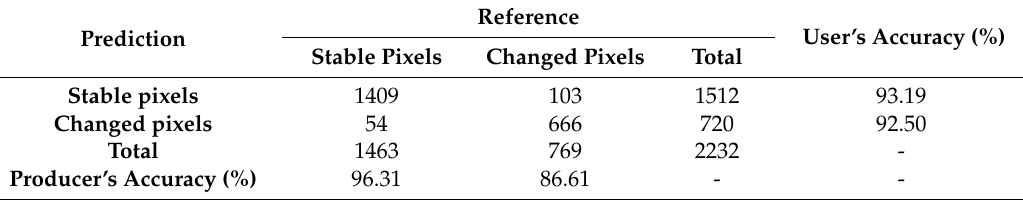
Table 5. Change detection assessment of the CCDC